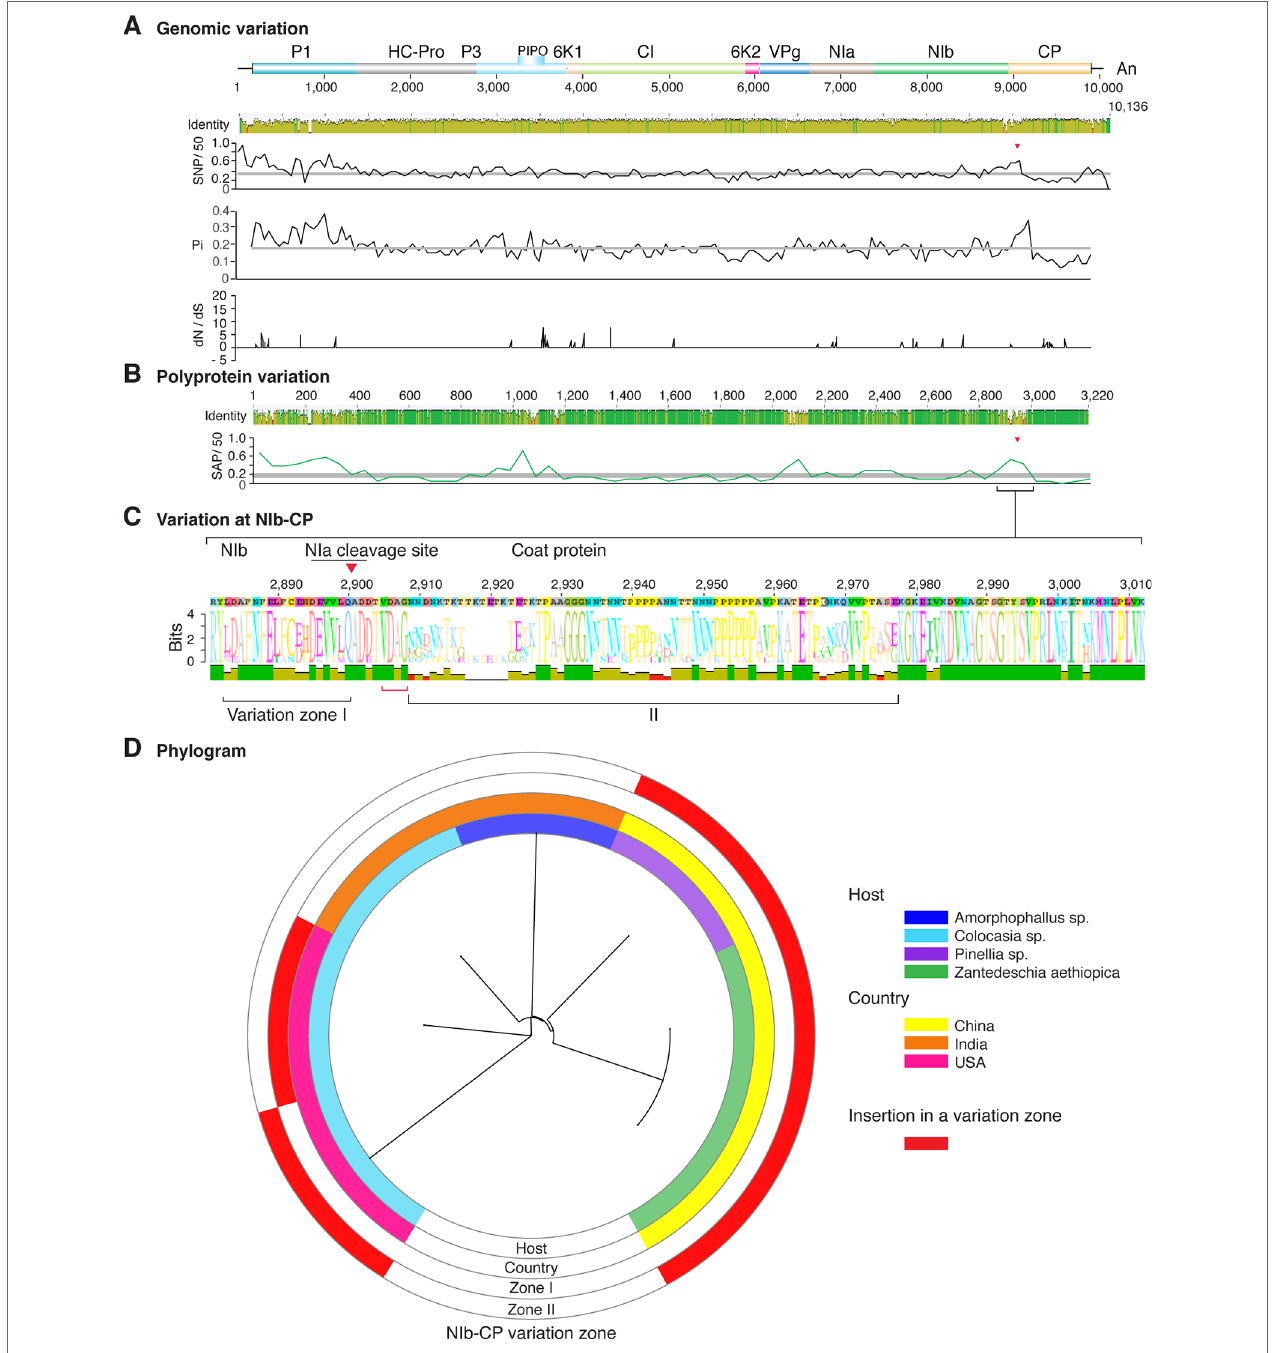
FiGUre 3 | Nucleotide and polyprotein variation in dasheen mosaic virus. Genome organization is shown to scale using accession JX083210 as reference. Labels are as in Figure 2 .